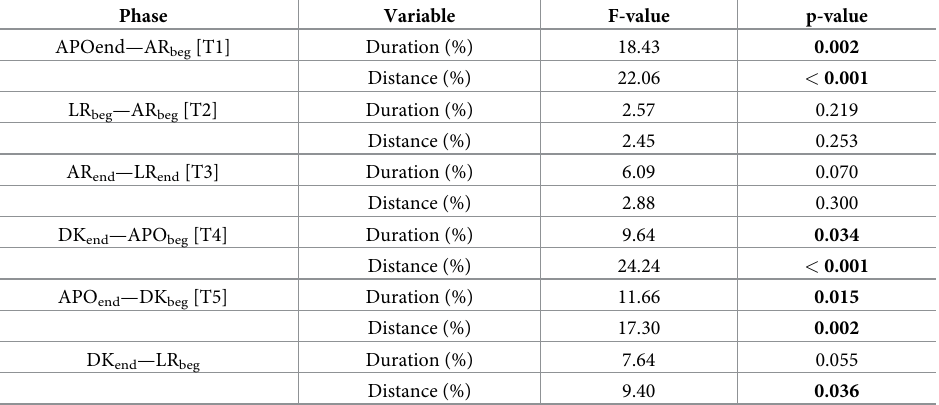
Table 5. Results from the mixed linear modelling assessing the effect of lap on the relative duration and distance of each time